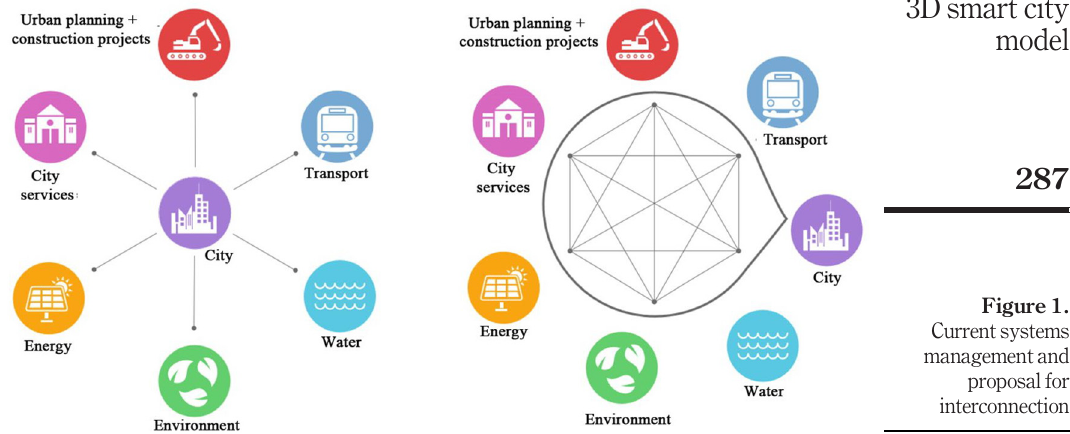
Figure 1. Current systems management and proposal for